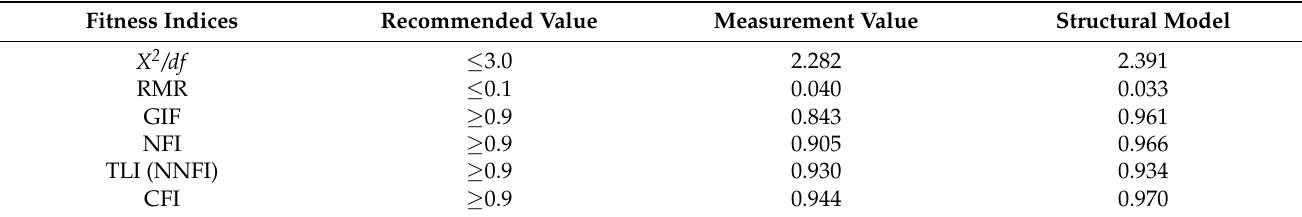
Table 4. Results of model compatibility measurement